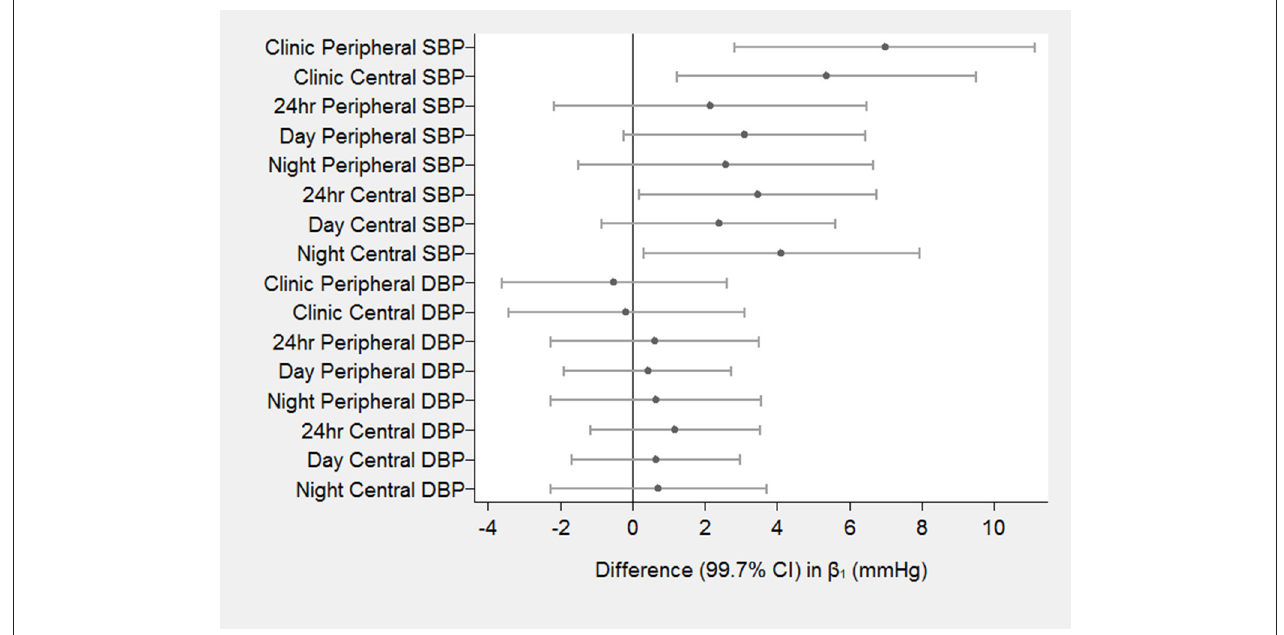
FIGURE 4 | Differences in the effects of baseline PWV on follow-up BP between DMARDS group and MTX group. The estimated effects ( β ) are the differences in increased blood pressure (in mmHg) at 8 months for a 1m/s higher baseline PWV for DMARDS vs. MTX.